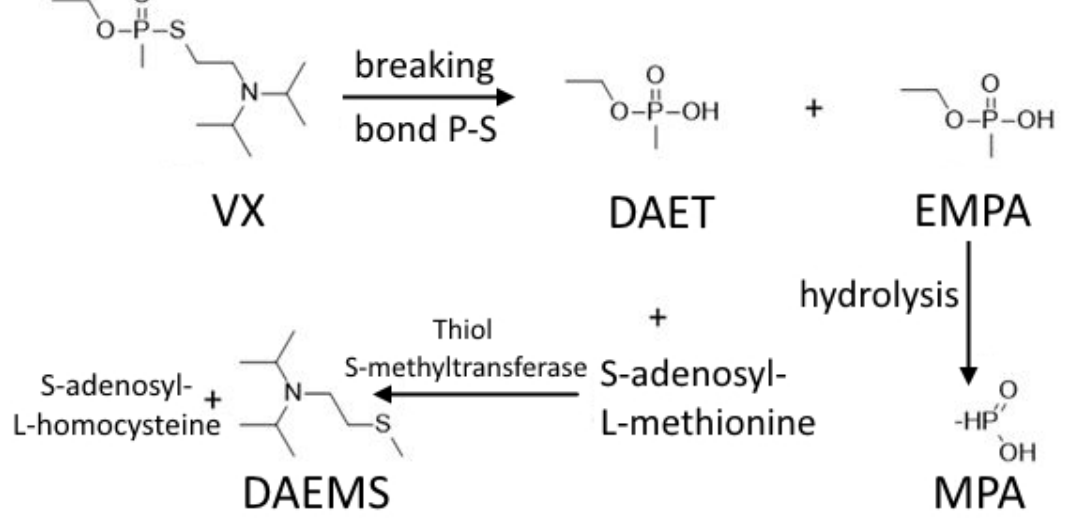
Figure 3. VX metabolic pathway in the human body. VX: N-[2-[ethoxy(methyl)phosphoryl]sulfonylethyl]-N-propan-2-ylpropan-2-amine, DAET: 2-(diisopropylamino)ethanethiol, EMPA: ethylmethylphosphonic acid, MPA: ethylmethylphosphonic acid, DAEMS: 2-(diisopropylaminoethyl)methylsulfide [59].